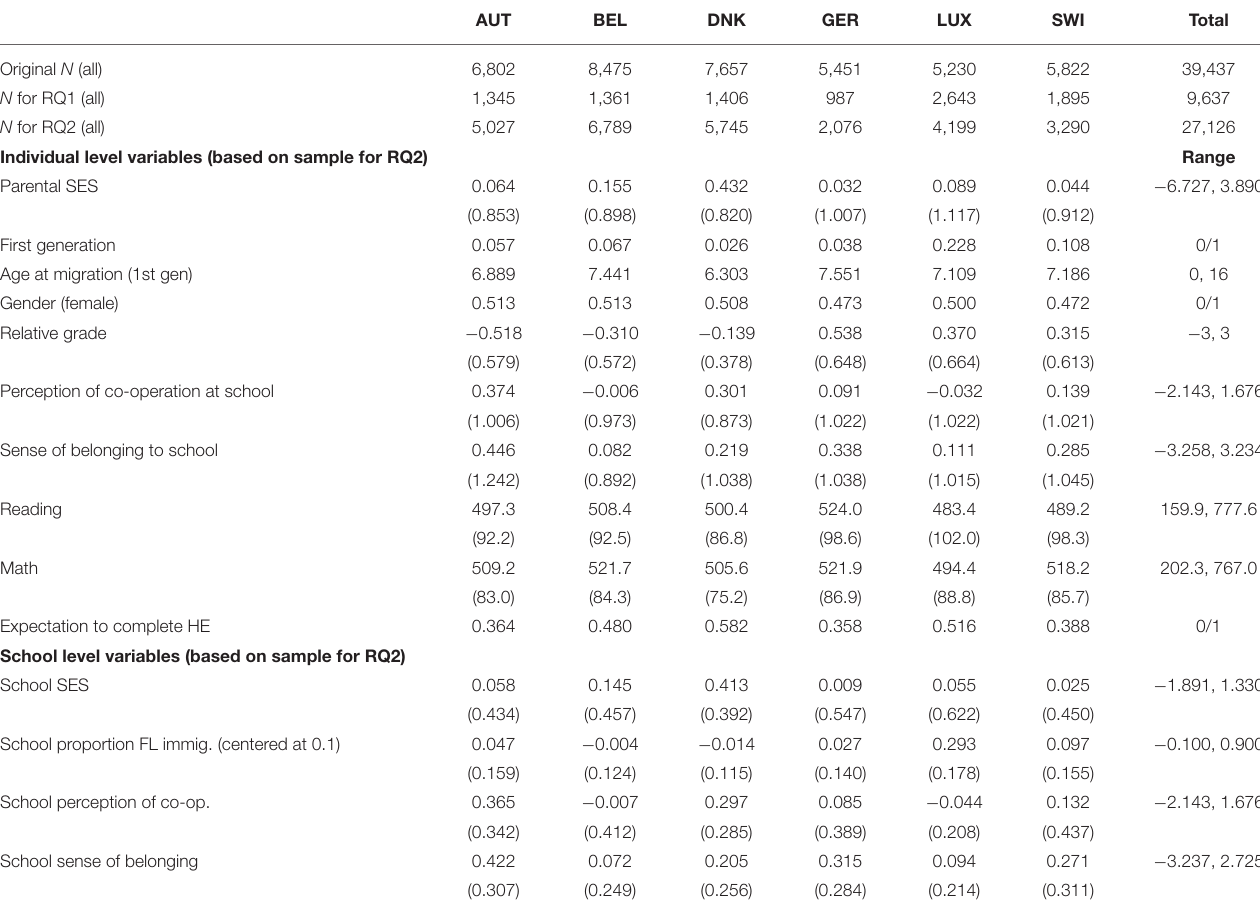
TABLE 1 | Descriptive information of samples and